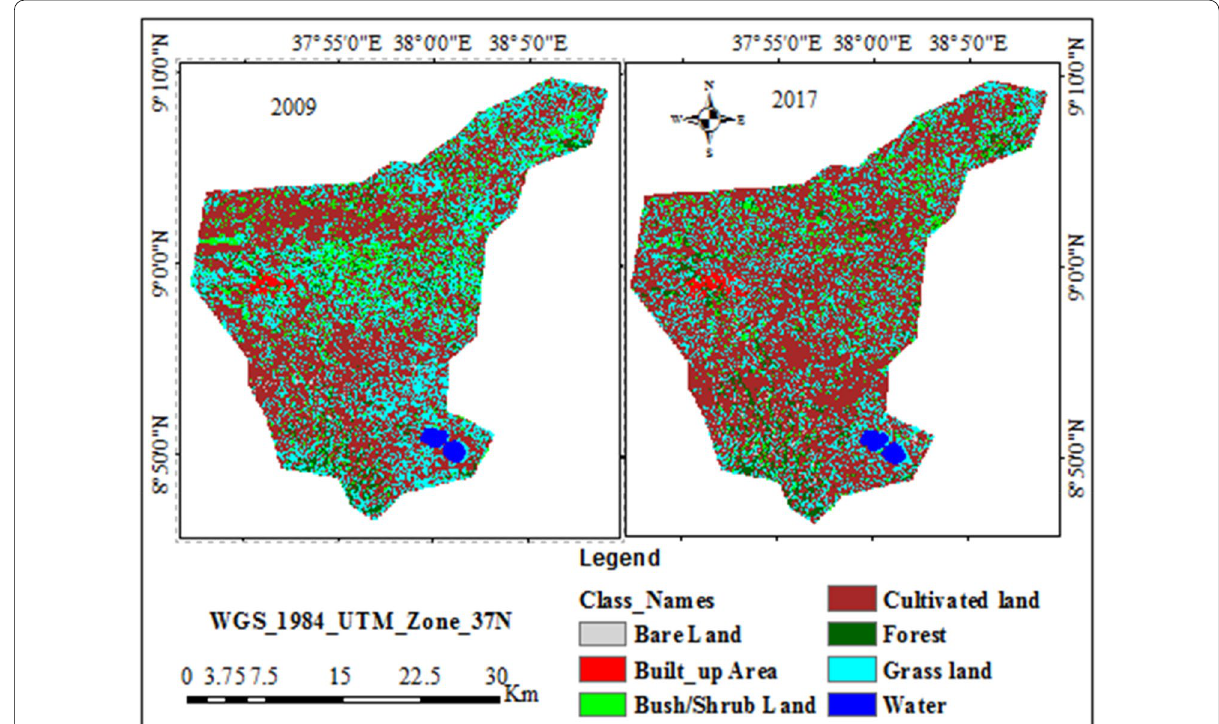
Fig. 5 Land use and land cover Maps of Huluka Watershed for 2009 and